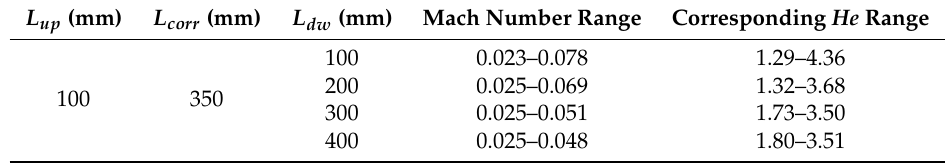
Table 6. Mach number and corresponding Helmholtz number ( He ) range for pipe systems in Case